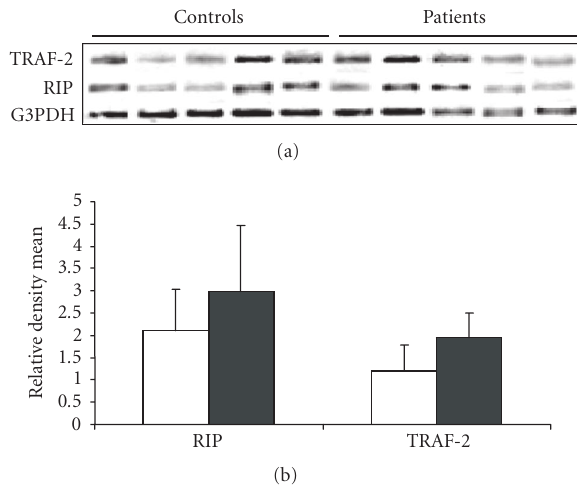
Figure 4: (a) Agarose gel (1.2%) showing gene expression profile of RIP and TRAF-2 from PBMCs of five representative healthy con- trols and RA patients. (b) Graph showing the relative density mean of 30 healthy controls and 27 RA patients for the expression of RIP and TRAF-2